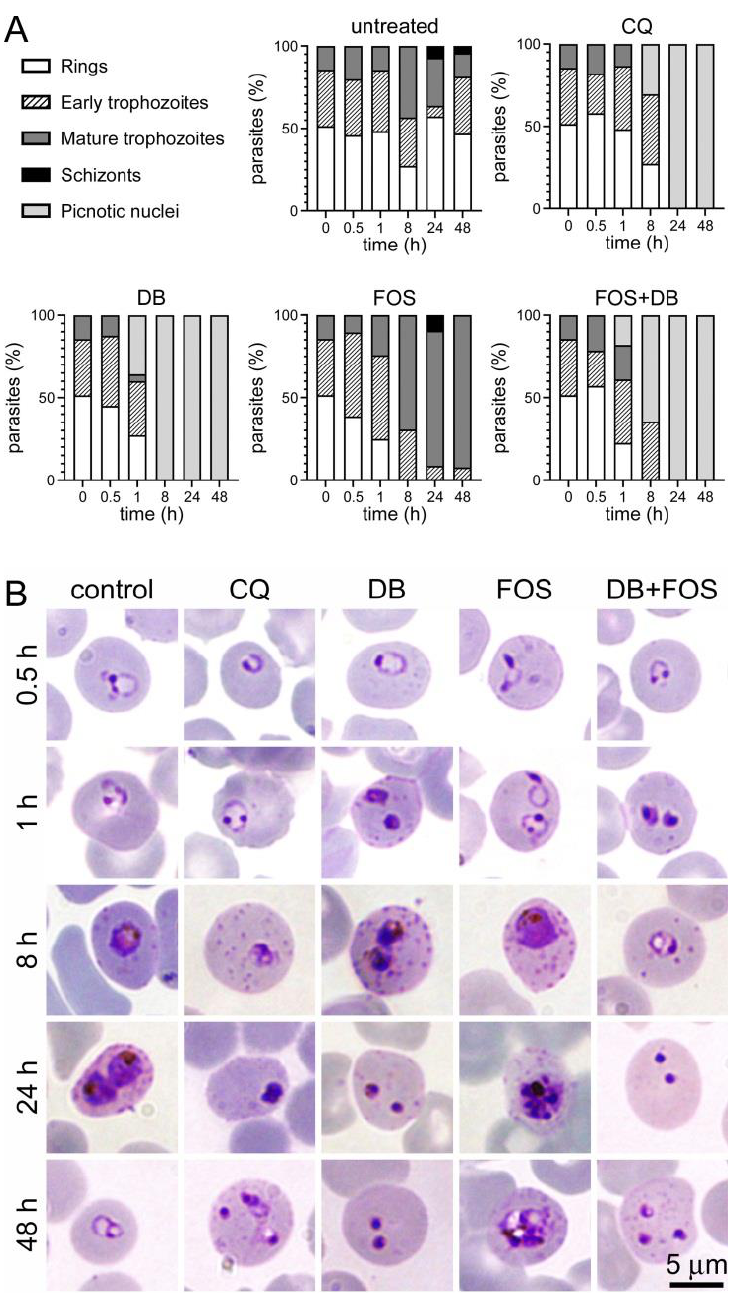
Figure 3. Effect of DB and fosmidomycin (FOS) on in vitro P. falciparum cultures. ( A ) Stage of growth inhibition of P. falciparum during 48 h of treatment with 20 µ M DB, fosmidomycin, and both drugs combined. Controls included a non-treated sample and a culture treated with 20 µ M chloroquine (CQ). Giemsa-stained blood smears were prepared at the indicated time points between 0 and 48 h of incubation, and the numbers of ring stages, early trophozoites, mature trophozoites, schizonts, and cells with picnotic nuclei were counted. Bars indicate the percentages of developmental stages present in the respective blood smears. ( B ) Representative images of Giemsa-stained P. falciparum blood stages at different times after the addition to the culture of antiplasmodial drugs.